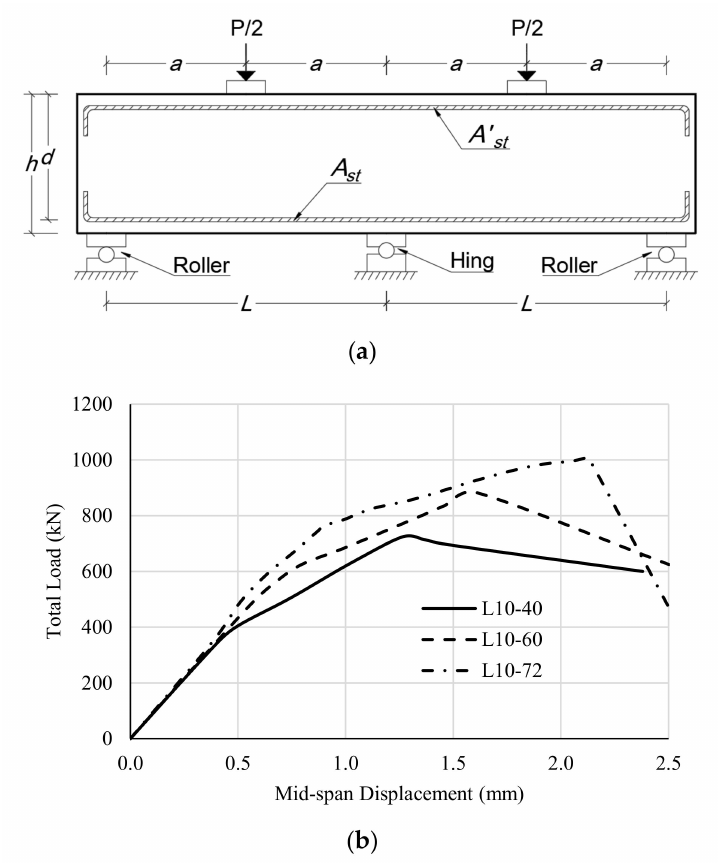
Figure 1. ( a ) Details of beam geometry and support conditions; ( b ) experimental total load-midspan displacement relations [9].